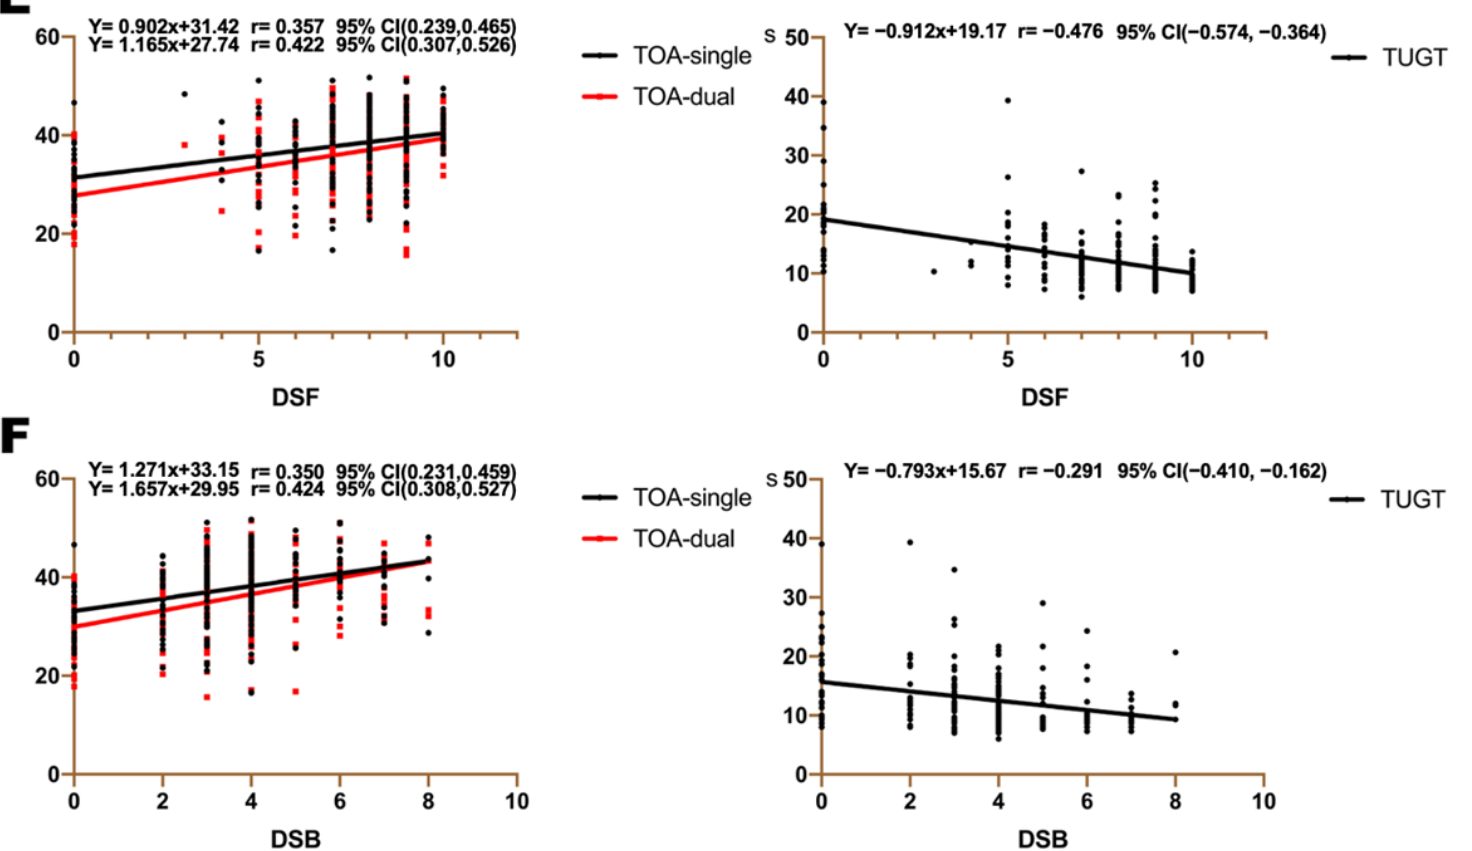
Figure 3. Correlations between gait indications and cognitive scales. Correlations between TOA, TUGT and ( A ) MMSE, ( B ) CDT, ( C ) TMT A, ( D ) TMT B; ( E ) DSF; ( F ) DSB; r = correlation coefficient. Abbreviations: MMSE, Mini-Mental State Examination; CDT, Clock-Drawing Test; TMT A, Trail Making Test A; TMT B, Trail Making Test B; DSF, Digit Span Test forward; DSB, Digit Span Test backward; TOA, toe-off ground angle; TUGT, timed “Up & Go” time.